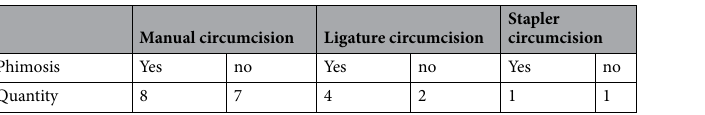
Table 8. Phimosis and secondary epidermoid cyst of the penis. Statistical analysis found that the presence of phimosis increased the probability of secondary epidermoid cysts of the penis regardless of the total proportion or the comparison of different surgical procedures.